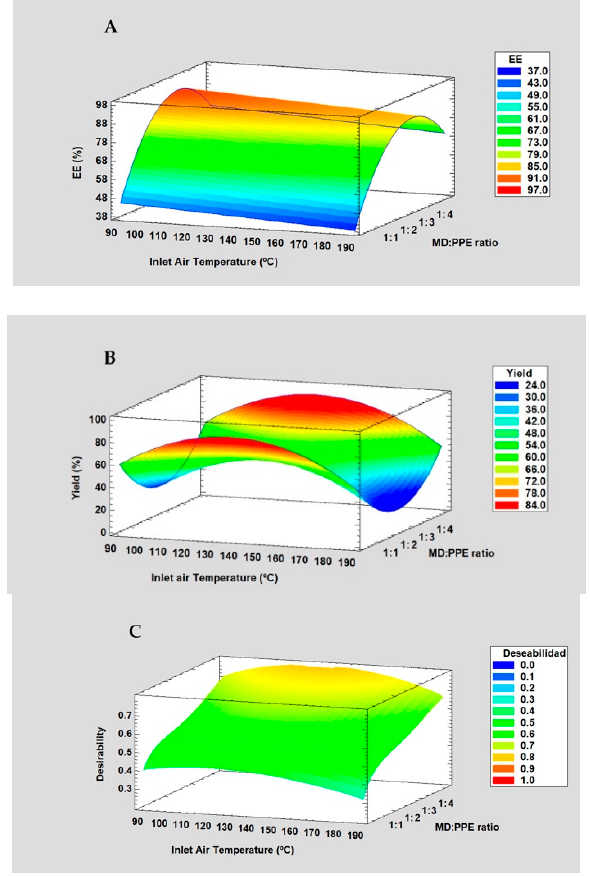
Figure 1. RSM plot for the EE of AT ( A) , the yield ( B ), and multiple optimization applying DF ( C ).